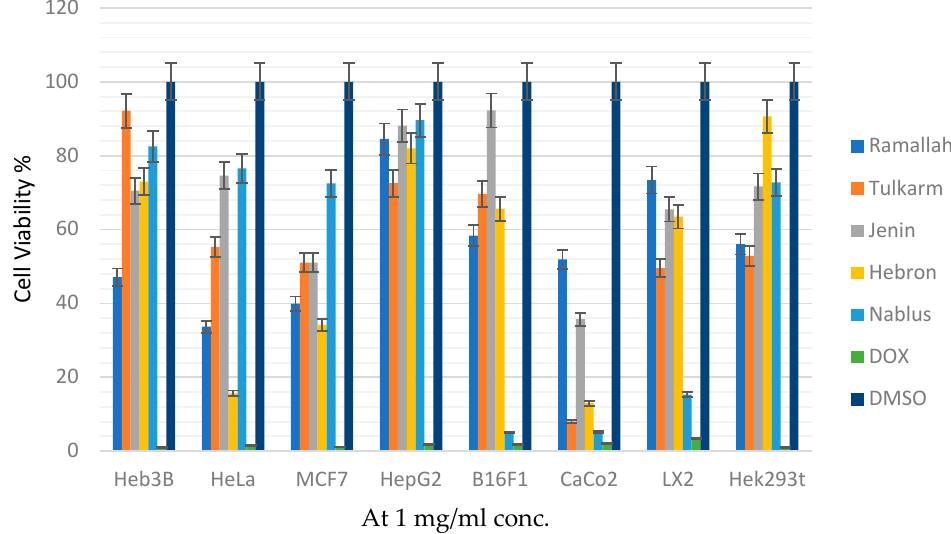
Figure 5. Cell viability % of R. officinalis essential oils collected from five different Palestinian regions, Dox and DMSO.